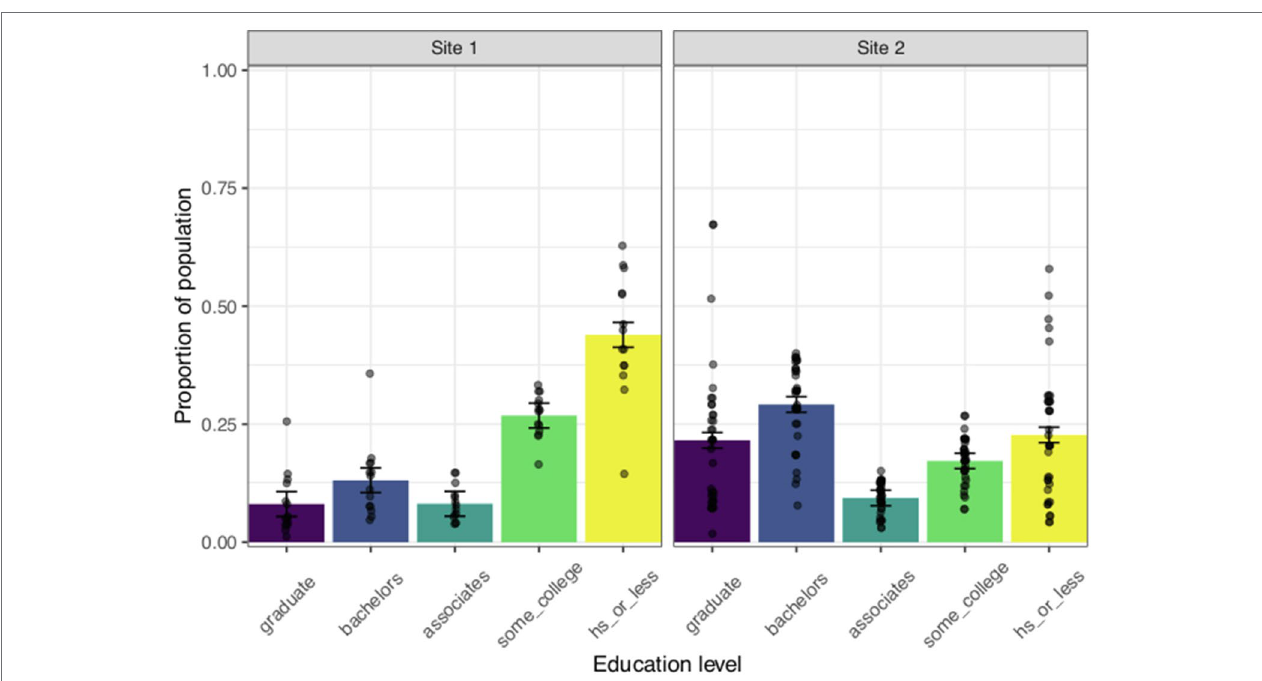
FIGURE 6 | Educational attainment by site location for respondents. Each bar represents the mean proportion of the population that has attained each education level for Site 1 (panel 1) and Site 2 (panel 2). Each data point represents the proportion of the population that has reached each education level for individual respondents’ census tracts. Error bars represent the